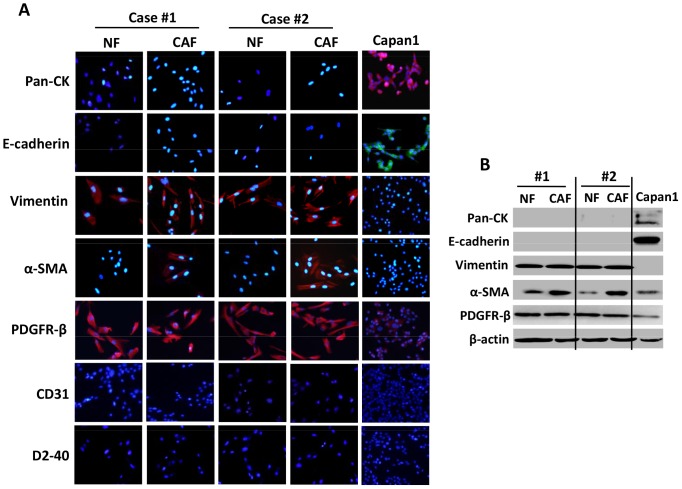
Generation and characterization of cancer-associated fibroblast cultures.A. Fibroblasts were extracted from the resected tissues of two pancreatic ductal adenocarcinomas. The purity of the cultured fibroblast cells was verified through immunofluorescence to detect Pan-CK (red), E-cadherin (green), vimentin (red), α-SMA (red), PDGFR-β (red), CD31 (red) and D2-40 (red). The cell nuclei were counterstained with DAPI (blue). Positive control tissues for CD31 and D2-40 immunostaining have been used (Figure S1). B. Western blot analysis confirmed the expression pattern of the markers used in A.